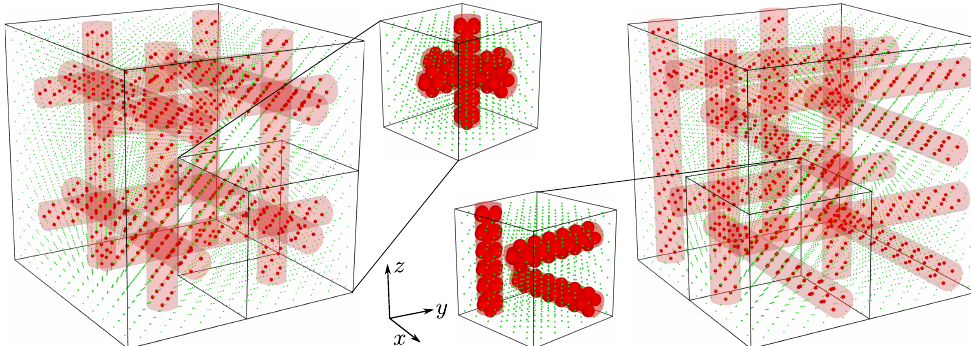
6 6 f.c.c. supercell × ×